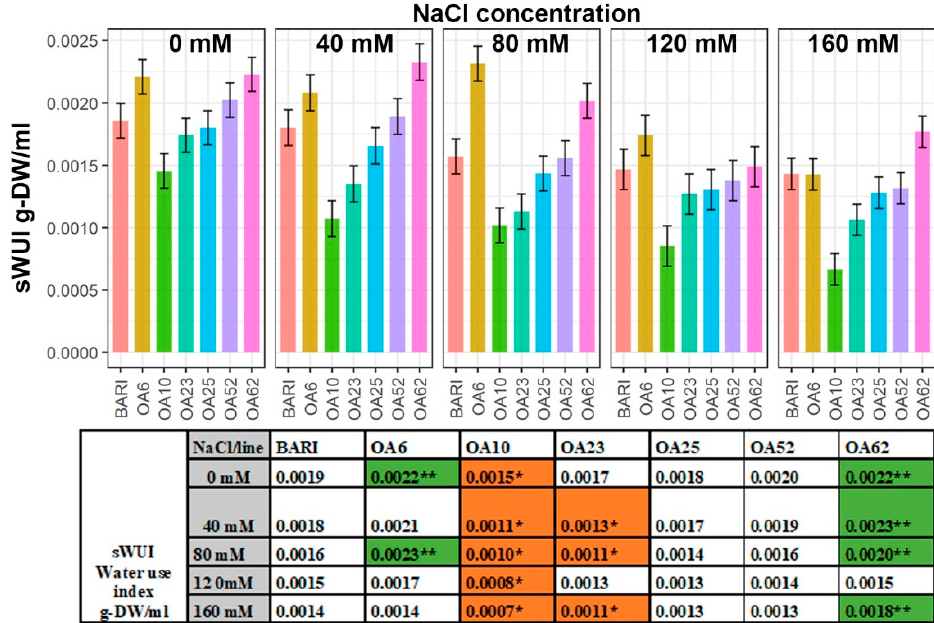
Figure 6. Water use index (sWUI) throughout the imaging period DAP 19–38. Data are shown for the control BARI Gom-25 (BARI) and mutagenized wheat lines OA6, OA10, OA23, OA25, OA52, and OA62 over DAP 19–39. NaCl concentrations applied were in the range from 0 mM to 160 mM. Upper panel: sWUI values with half-LSD error bars. Lower panel: table high-lighting the sWUI mean values with color codes for significantly higher (dark green **) or lower (orange *) values compared to BARI Gom-25, p ≤ 0.05.